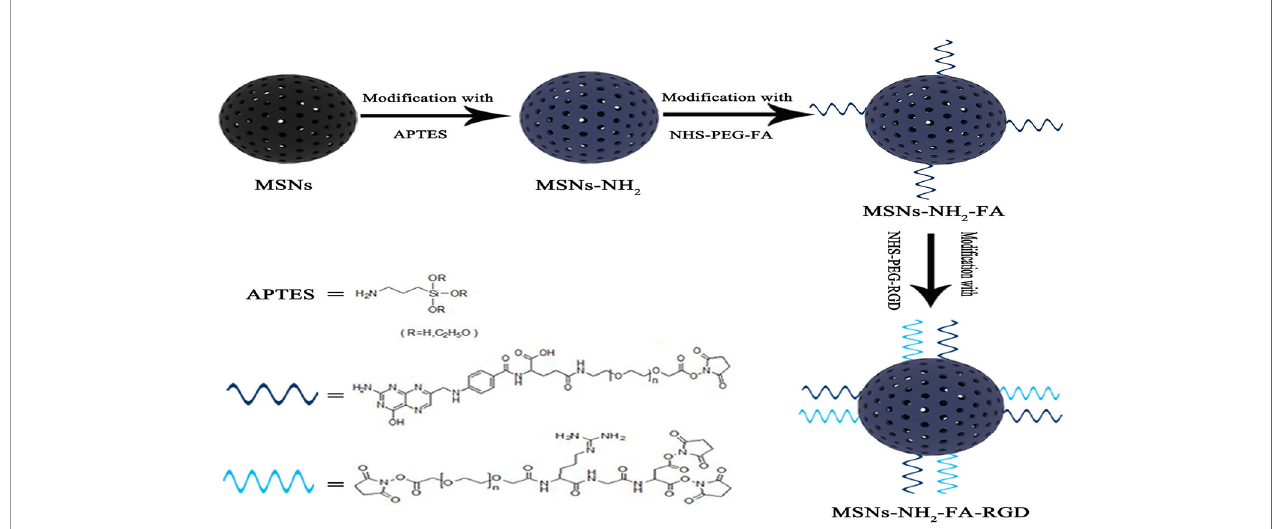
FIGURE 1 | Schematic illustration of preparation process of MSNs-NH 2